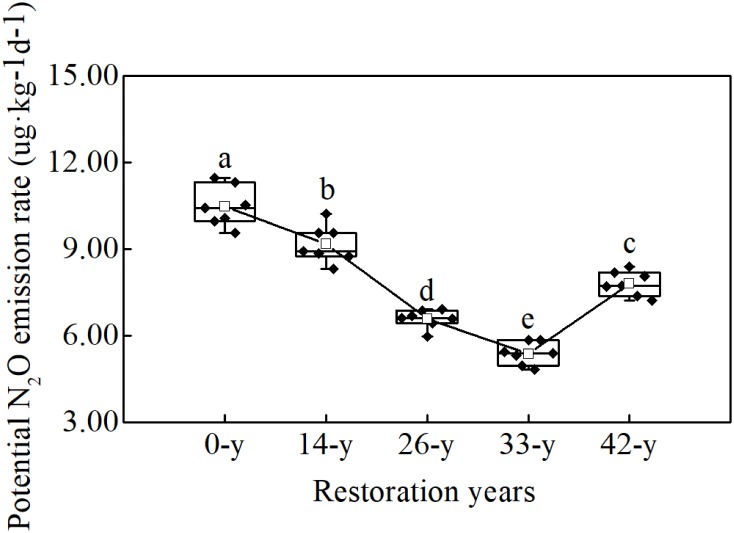
Different letters indicate significant differences (P < 0.05) among afforestation restoration ages based on a general linear model followed by an LSD post hoc test. The box plot shows the following information from top to bottom: maximum, upper quartile, median, lower quartile, and minimum. The white square shows the average value and the black line shows the trend. The black rhombus shows potential N2O emission rate data.